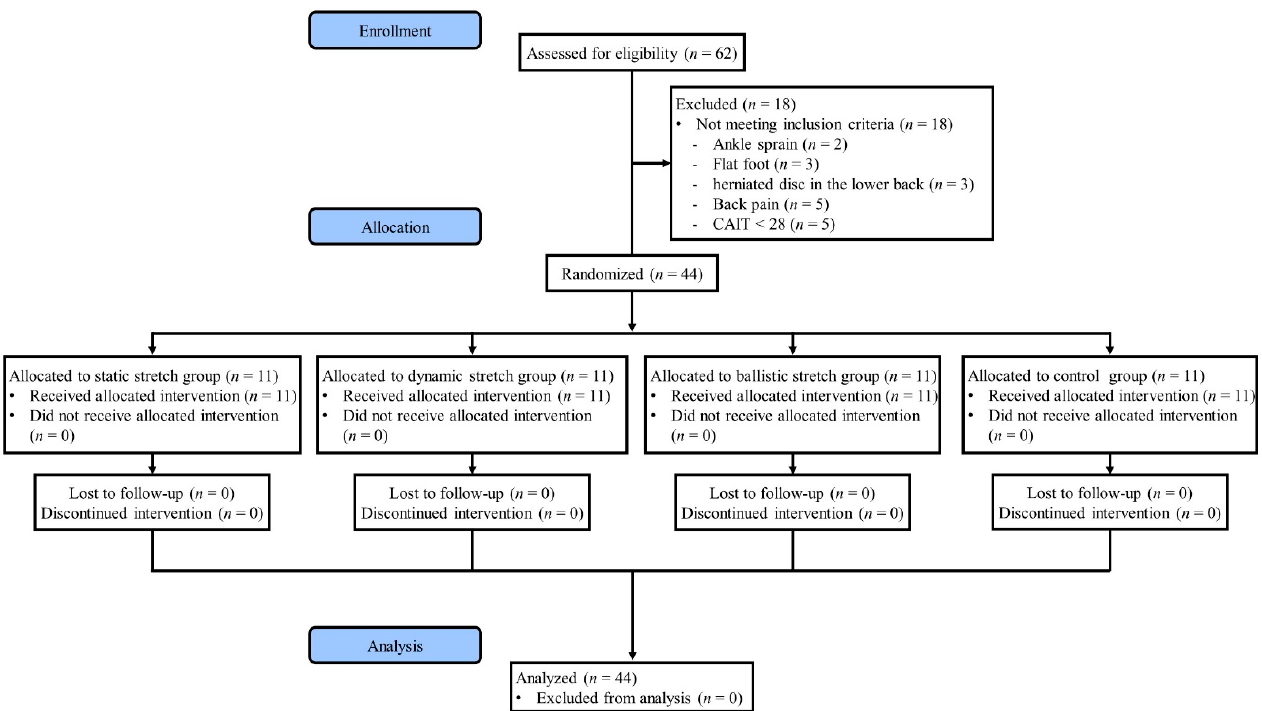
Figure 1. Flow chart in this study.